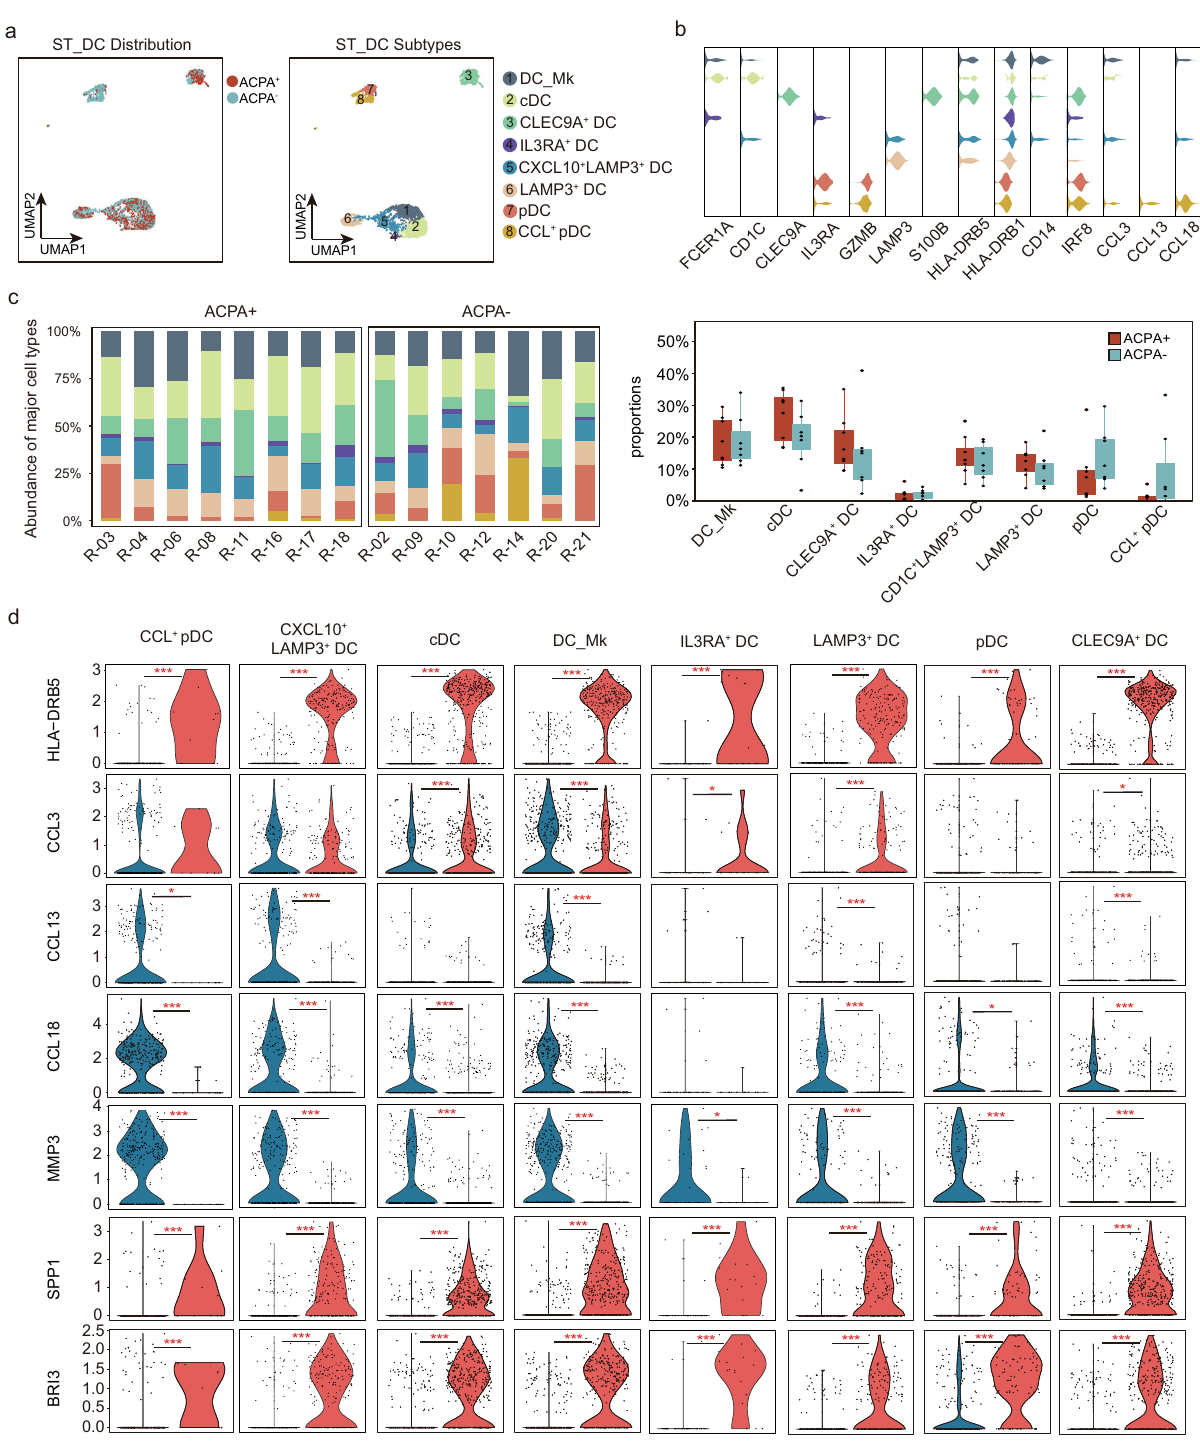
Fig. 4 Enrichment of CCL + DC subsets in synovial tissue from patients with ACPA- RA. a UMAP visualization of dendritic cell (DC) subtypes from the synovium. We identi fi ed eight DC clusters across 3369 cells. Cells are marked by ACPA type (left) and cell subtypes (right). b Violin plots showing marker genes across STMC DC subtypes. The y axis represents log-scaled normalized counts. c Left: bar plots showing the relative percentage of STMC DC subtypes for each sample as in a Right: box plots showing the proportions of each STMC DC subtypes across ACPA groups. n = 10 for ACPA + group, and n = 10 for ACPA- group. d Violin plots showing the differences in interested gene expression between ACPA- and ACPA + DC subtypes in STMC. Asterisks indicate the signi fi cance. The y axis represents log-scaled normalized counts. P values were calculated by the two-sided Wilcoxon test. * p < 0.05, ** p < 0.01, *** p <